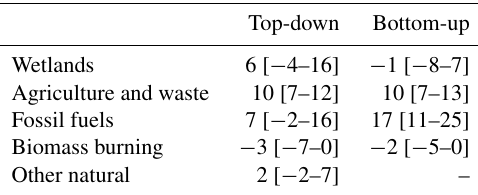
Table 4. Mean values of the emission change (in Tg CH 4 yr − 1 ) be- tween 2002–2006 and 2008–2012 inferred from the top-down and bottom-up approaches for the five general